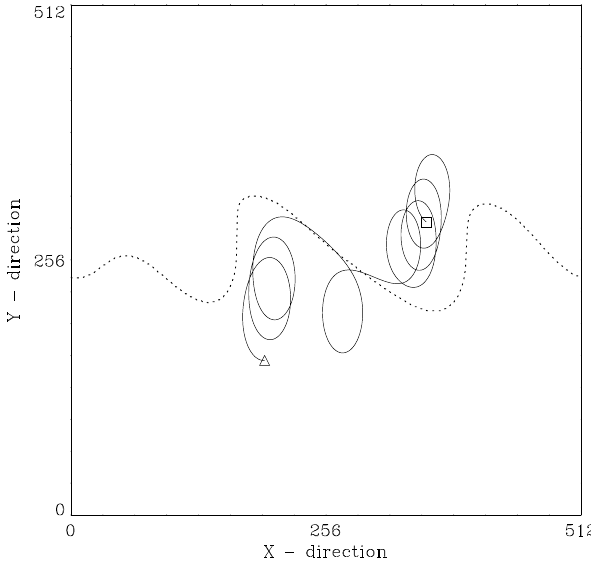
Fig. 4. Particle orbit crossing the interface in a nonadiabatic manner. The test particle starts in the MSP (square) and ends up in the MSH (triangle).